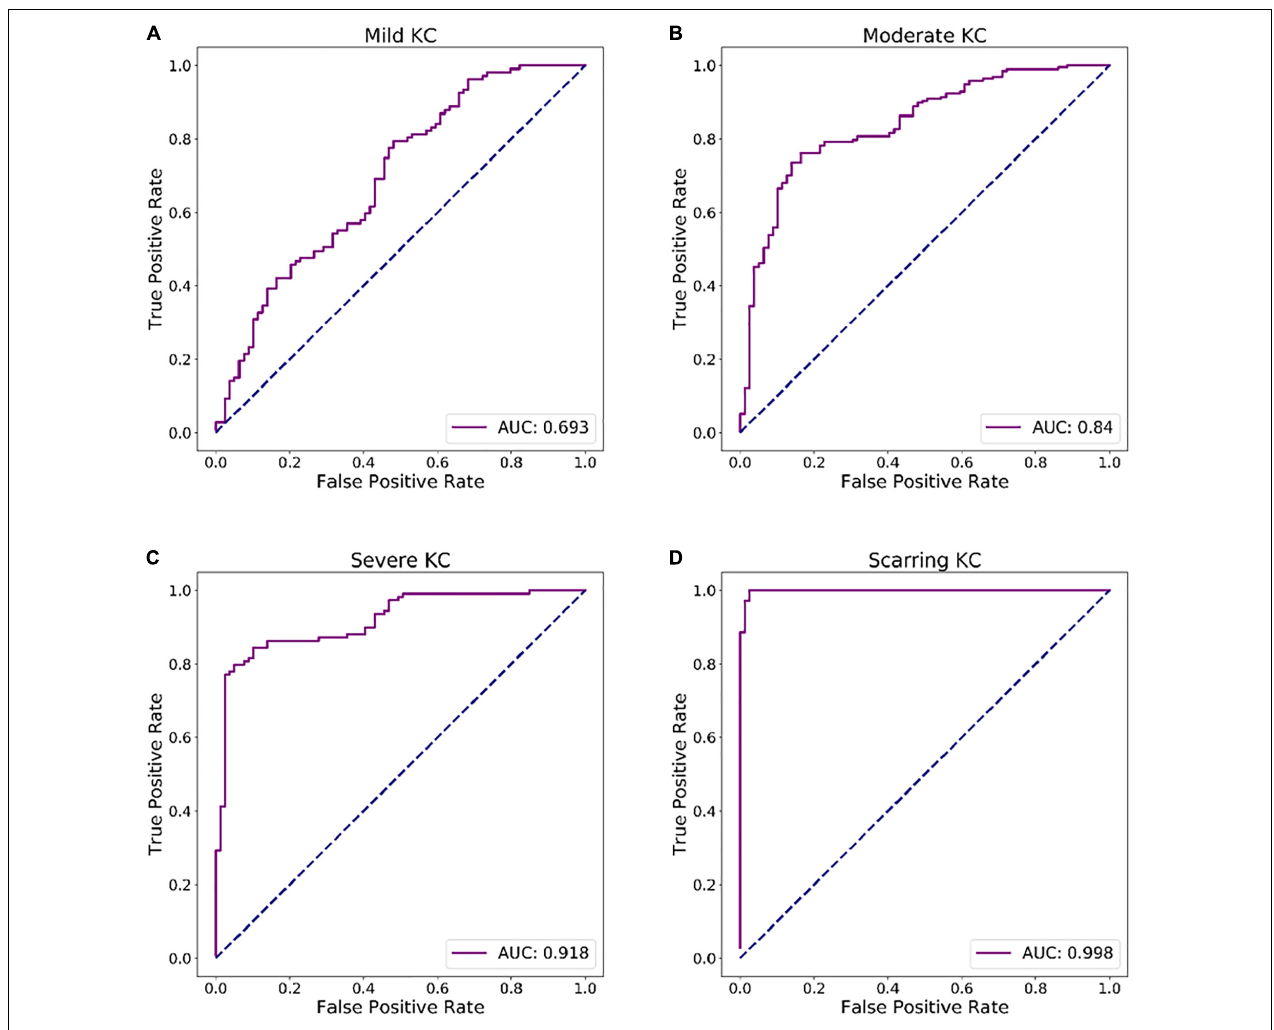
FIGURE 4 | ROC curves of discriminant functions in differentiating the groups with different KC stages from the normal group. (A) ROC curve of discriminant function for mild KC vs. the normal group. (B) ROC curve of discriminant function for moderate KC vs. the normal group. (C) ROC curve of discriminant function for severe KC vs. the normal group. (D) ROC curve of a discriminant function for scarring KC vs. the normal